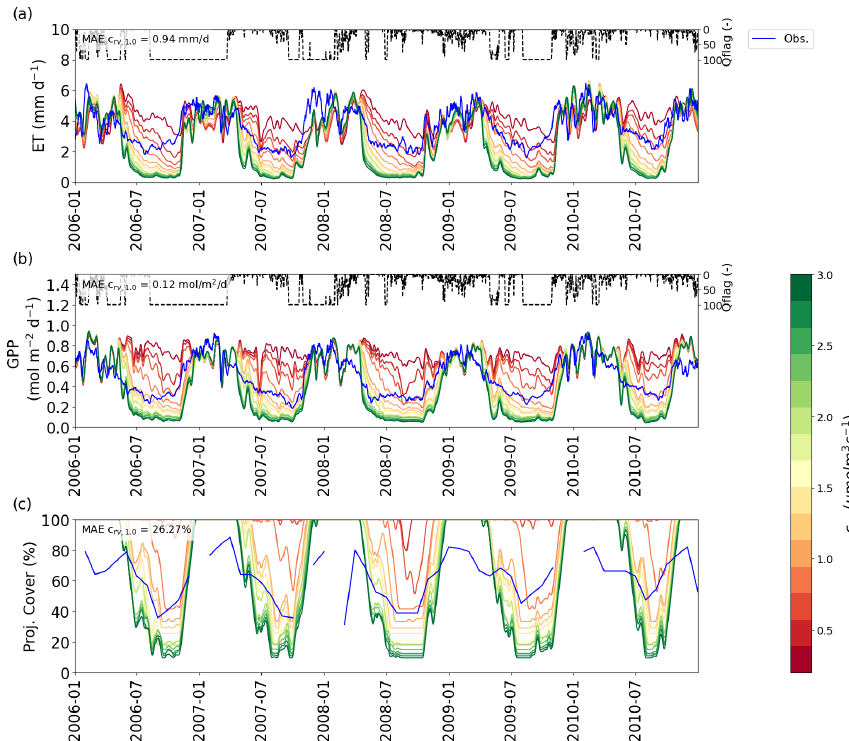
Figure 4. VOM results for different values of the cost factor c rv (colour scale) for Howard Springs for 2006–2010 (as a subset from 1980 to 2017), with (a) the ET, with flux tower observations in blue, (b) GPP, with flux tower observations in blue, and (c) projective cover, with the observed fraction of vegetation cover based on fPAR data (Donohue et al., 2013) in blue. The time series for ET and GPP are all smoothed with a moving average with a window of 7d. Daily average quality flags for the flux tower observations are added on top and range from 0 (no missing values) to 100 (completely gap-filled). In each panel, the mean absolute error (MAE) is given for the simulation with c rv = 1 . 0µmolm − 3 s − 1